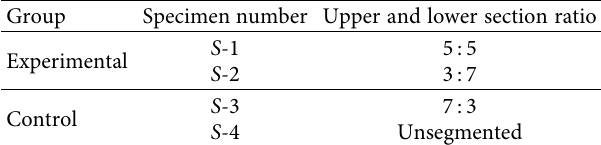
Table 2: Experimental design.